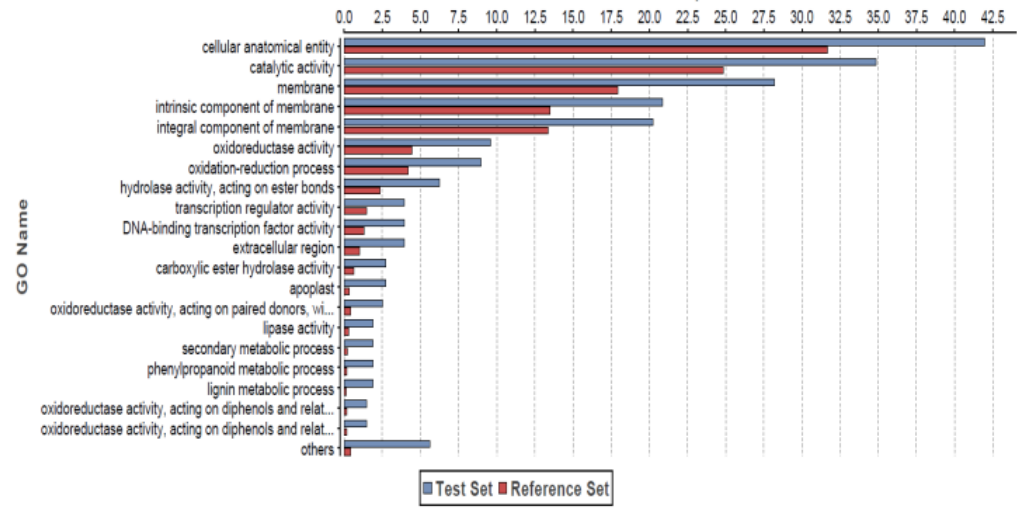
Figure 4. GO enrichment analysis of the differentially expressed genes using Fisher’s exact test with a p -value cutoff applied as 0.05. The X-axis is the percentage of genes mapped by the term and represents the abundance of the GO term. The percentage for the input list is calculated by the number of genes mapped to the GO term divided by the number of all genes in the input list. The same calculation was applied to the reference list to generate its percentage. These two lists are represented using different custom colors. The Y-axis is the definitions of the GO terms.